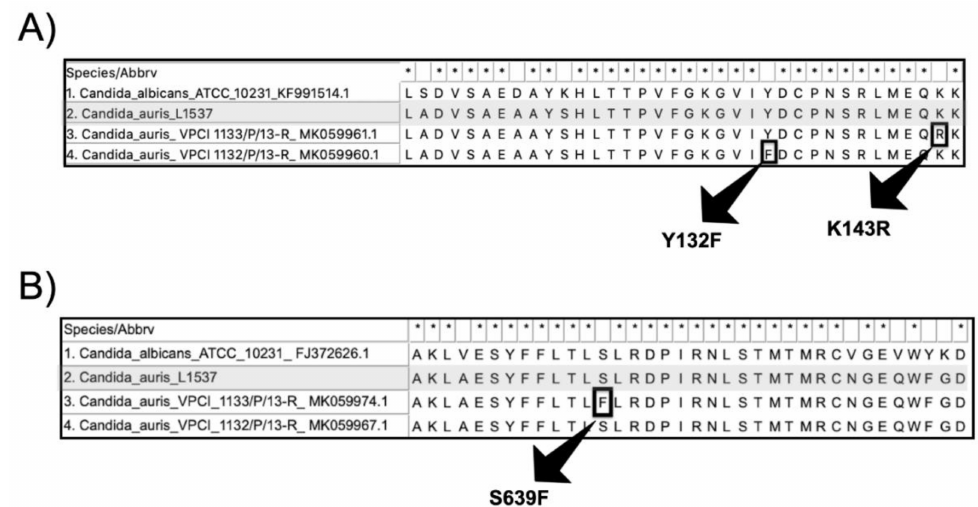
Figure 3. ( A ) Erg11p alignment showing the conserved region between the sites 119 and 145 including the azole wildtype Candida albicans ATCC 10231 (1), the Brazilian Candida auris strain L1537 (2), the strain VCPI 1133/P/13-R harboring the mutation K143R (3), and the strain VCPI 1132/P/13-R harboring the mutation Y132F. The azole resistance-related amino acid substitutions K143R and Y132F are highlighted with black squares; ( B ) Fks1p alignment showing the conserved region between the sites 627 and 662 including the echinocandin wildtype Candida albicans ATCC 10231 (1), the Brazilian Candida auris strain L1537 (2), the strain VCPI 1133/P/13-R harboring the mutation S639F (3), and the echinocandin wildtype strain VCPI